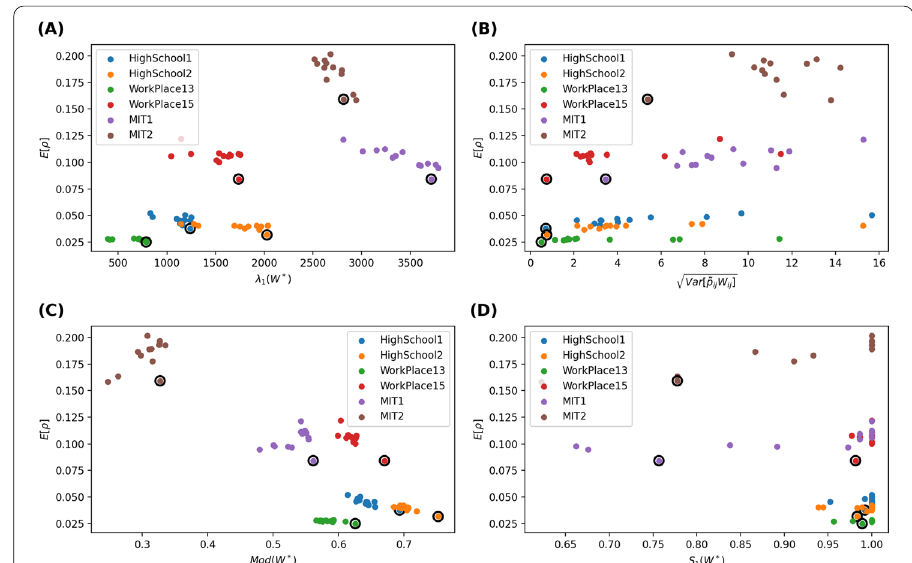
Fig. 2 Scatter plot of the average prevalence E [ ρ ] versus the largest eigenvalue (cid:31) 1 ( W ∗ ) of the aggregated pruned network ( A ), the standard deviation (cid:31) Var [˜ p ij w ij ] of the average number of contacts removed from a node pair ( B ) the modularity Mod ( W ∗ ) ( C ) and the relative size of the largest connected component of the aggregated pruned network ( D ), respectively. A fraction φ = 10% of the contacts are removed. The recovery rate is γ = 0 per step. The results obtained with 1/link weight strategy are circled